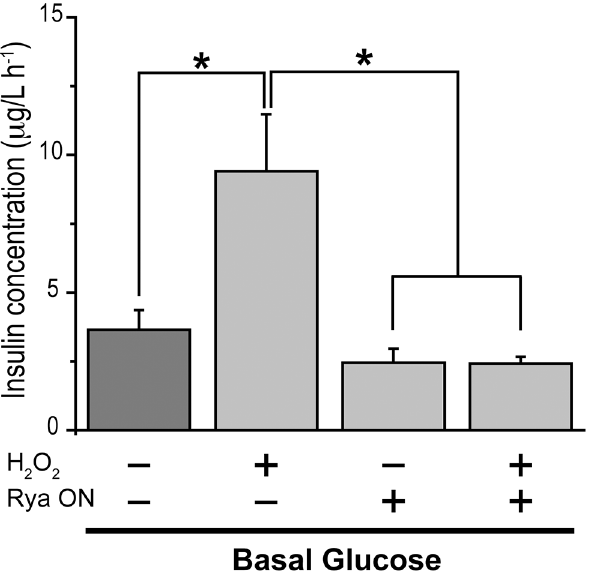
Fig 6. RyR inhibition prevents H 2 O 2 -dependent insulin secretion. Islets were pre-incubated for 1 h at 37°C in Krebs bicarbonate buffer supplemented with 2.8 mM glucose. Groups of 15 islets were then incubated for 1 h at 37°C in the presence or absence of 100 μ M H 2 O 2 in basal glucose (2.8 mM) to measure insulin secretion. Rya ON: islets were pre-incubated with 200 μ M ryanodine for 12 h before the 1 h incubation period used to measure insulin secretion. Values represent Mean ± SEM; N = 3. Statistical significance was determined with one-way ANOVA followed by Tukey multiple comparison test. * : p < 0.05.